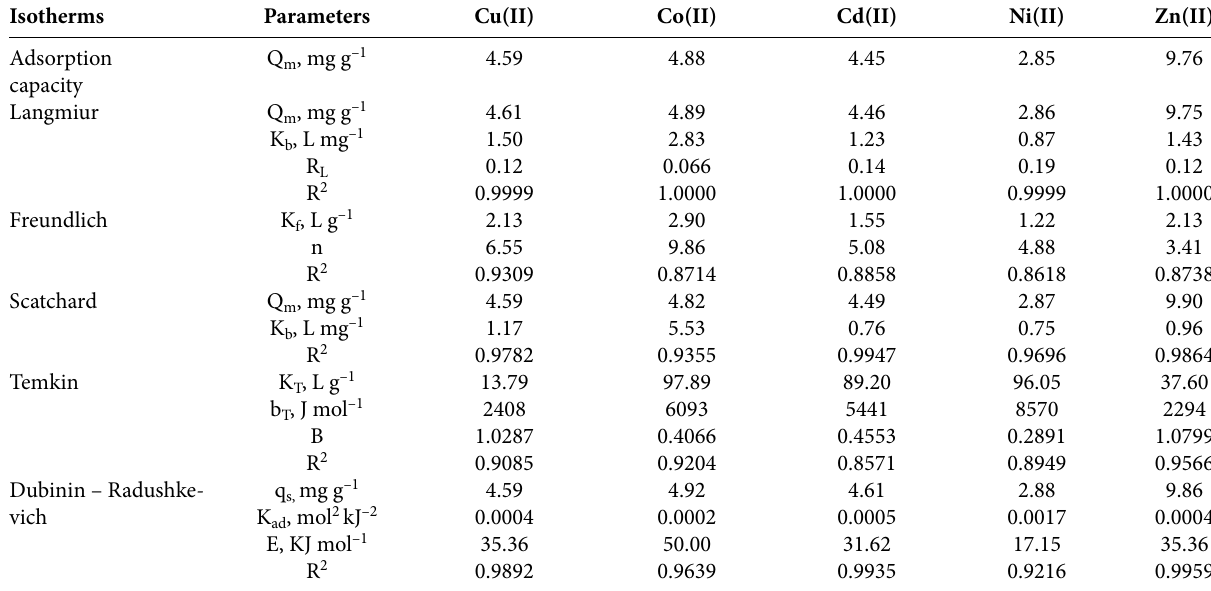
Table 3. Langmuir, Freundlich, Scatchard, Temkins and Temkin Dubinin–Radushkevich isotherm parameters for the adsorption of examined met- al ions by Fe 3 O 4 @PTh Isotherms